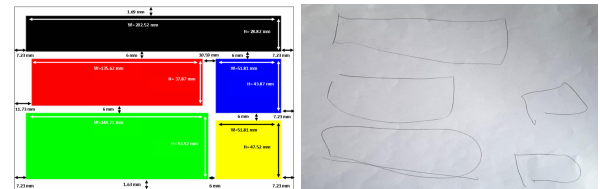
Figure 11. Sample Drawings of D4 in reference to the e-commerce structure.